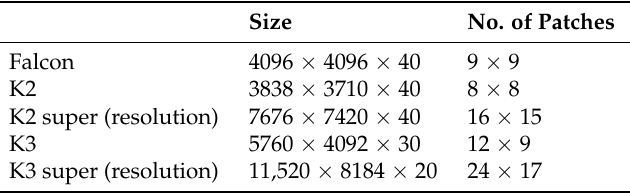
Table 3. Resolution and number of frames used for